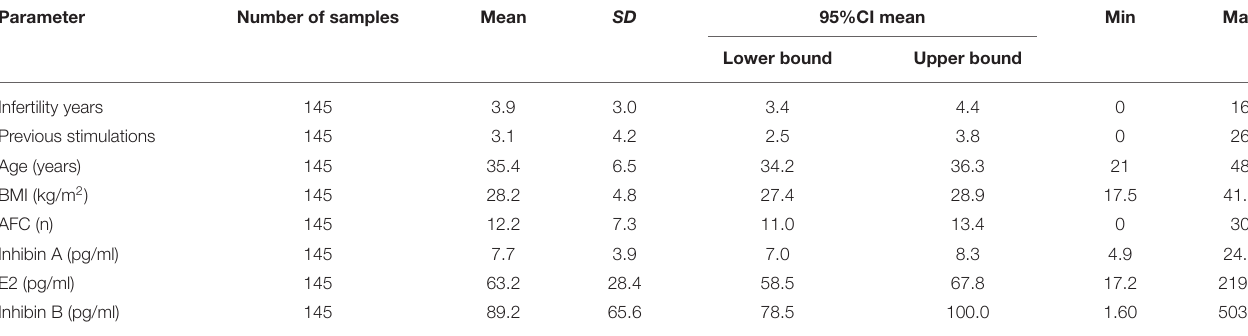
TABLE 1 | Patients’ characteristics and results of AFC, serum levels of Inhibin A, E2, and Inhibin B on cycle day 2 or 3. Parameter Number of samples Mean